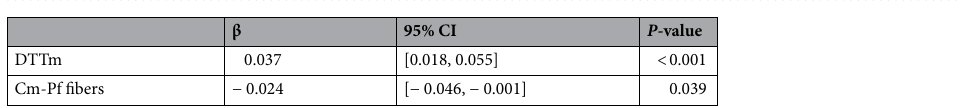
Table 1. Multivariable mixed effects regression model testing differences in behavioral performance over predicted activation of DTTm and Cm-Pf